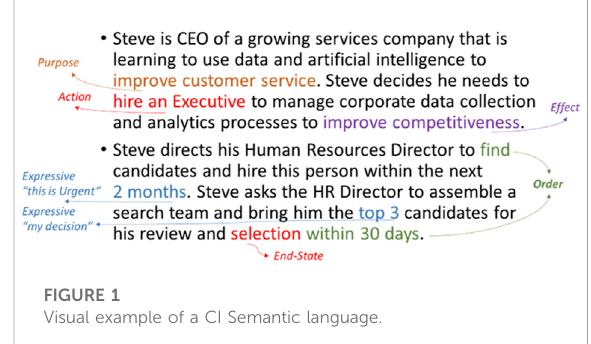
Visual example of a CI Semantic language.